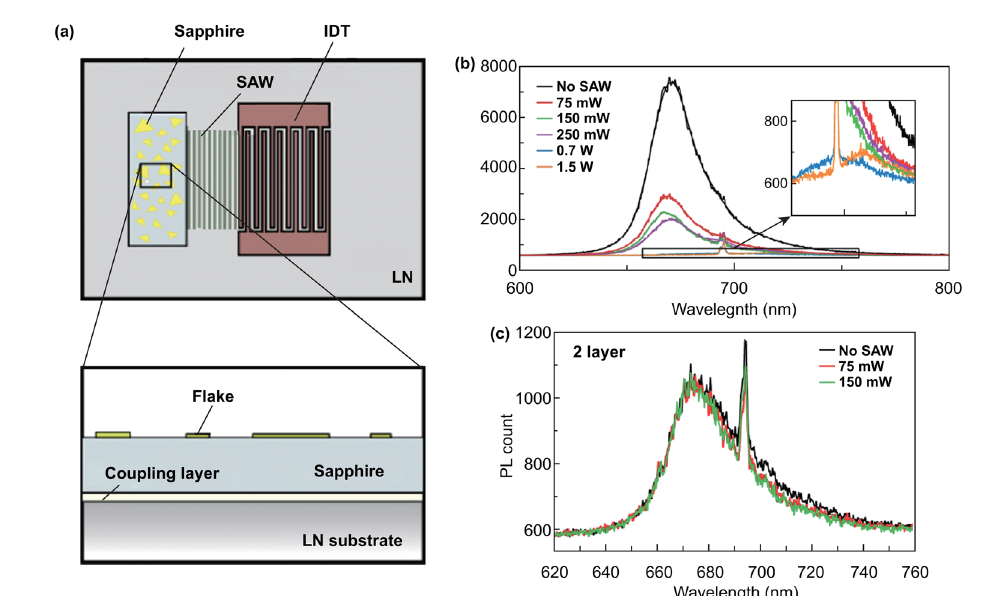
Fig. 14 Applied strain to 2D semiconductors by surface acoustic wave. a Schematic illustration of the experimental setup comprising the SAW device, which consists of IDT electrodes photo-lithographically patterned on a lithium niobate substrate. PL spectra of b a monolayer and c bilayer MoS 2 flake with respect to a range of SAW input powers. Reproduced with permission [182]. Copyright 2017, American Chemical Soci-